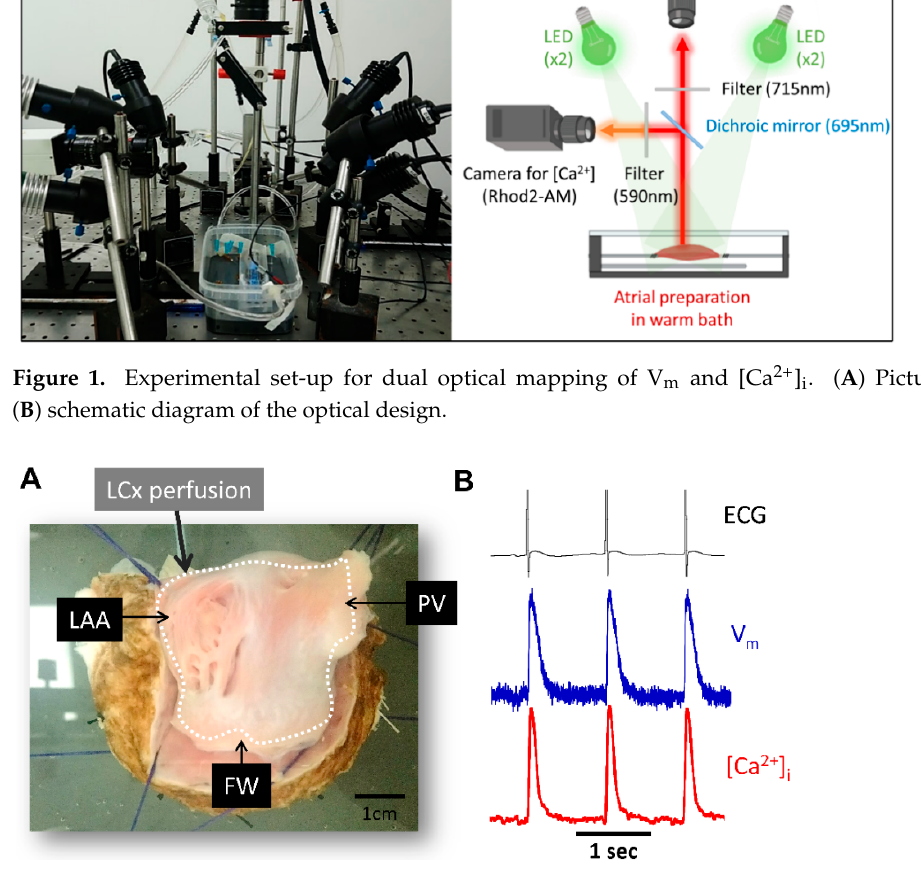
Figure 2. Experimental preparation and signal examples recorded during atrial pacing. ( A ) Picture of LA endocardial surface preparation. ( B ) Representative ECG signals (black), optical action poten- tial (blue) and calcium transient signals (red) during pacing at pacing cycle length = 1000 ms. PV, pulmonary veins; LAA, left atrial appendage; FW, free-wall; LCx, left circumflex coronary artery.